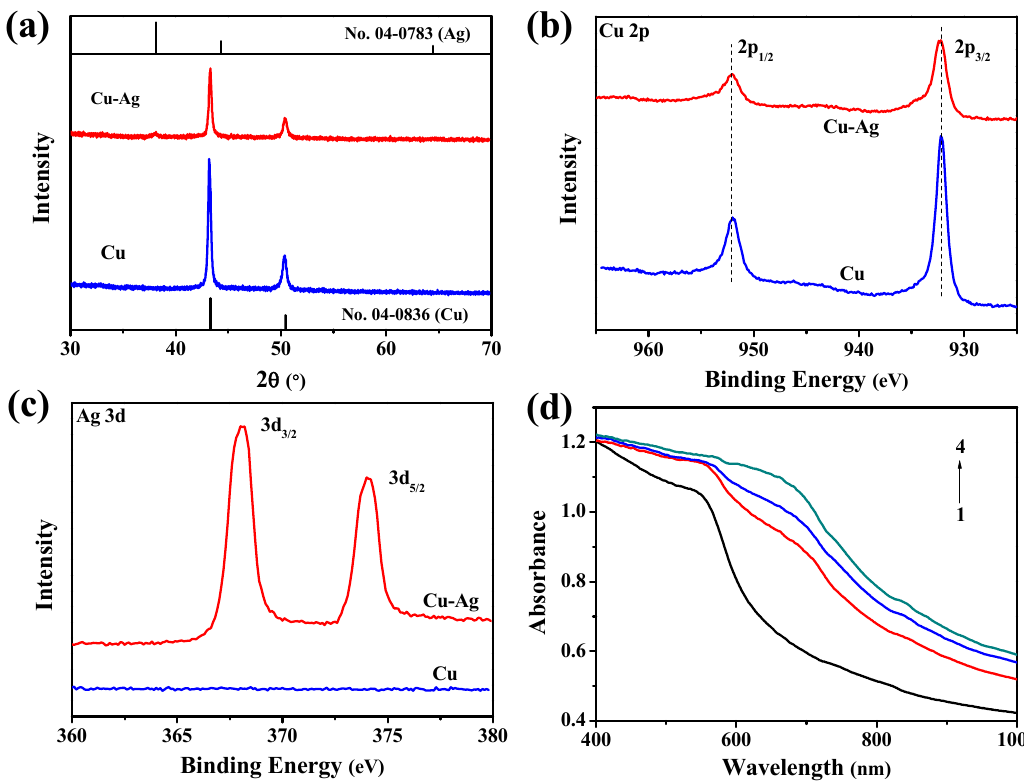
Figure 2. XRD patterns ( a ), XPS high resolution spectra of Cu 2p ( b ), Ag 3d ( c ) of the Cu and Cu-Ag chips. ( d ) VIS-NIR diffuse reflectance spectra of Cu-based fabrics with the Ag replacement Table 1. 0, (2) 1, (3) 3 and (4) 5 min in the preparation.